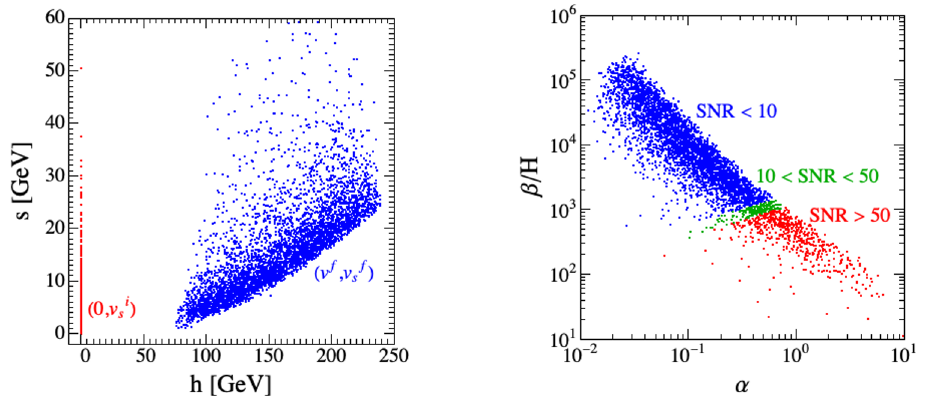
Figure 1 . Left: the collection of vacuum decay initial states (0 , v i (blue). Right: the SNRs for the SFOEWPT data projected at the α - β/H plane.